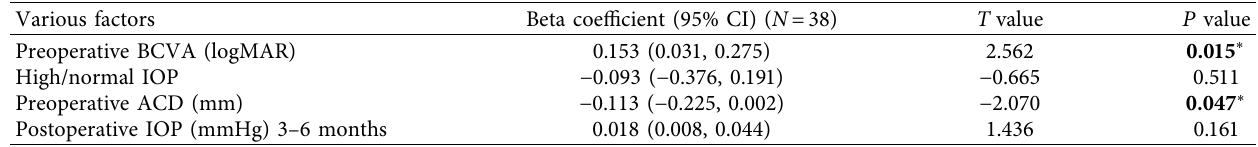
Table 4: Multivariate analysis of factors associated with postoperative BCVA at 3–6 months.